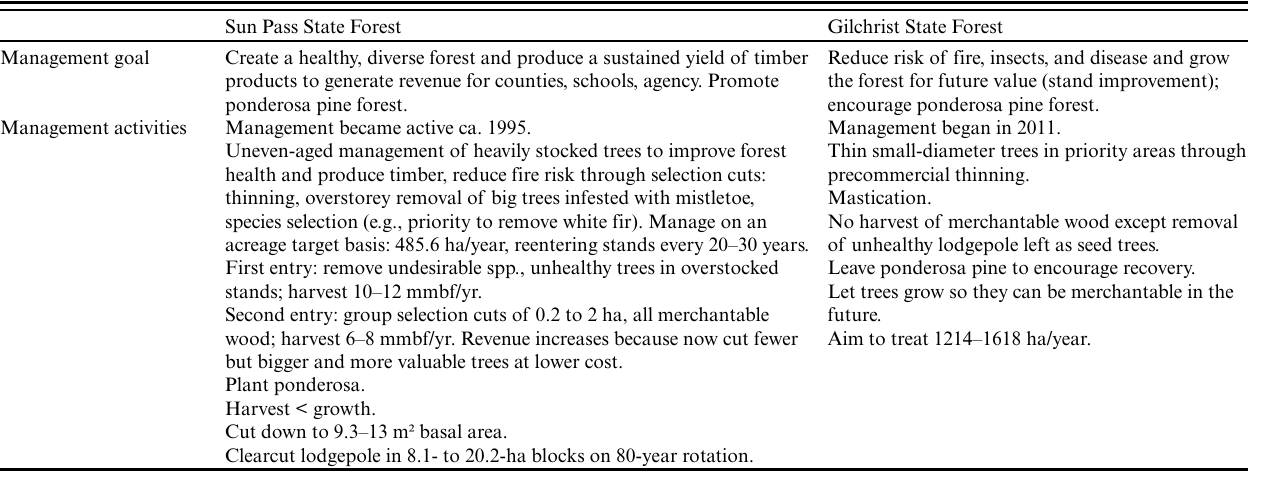
Table 4. Forest management, State forests Sun Pass State Forest Gilchrist State